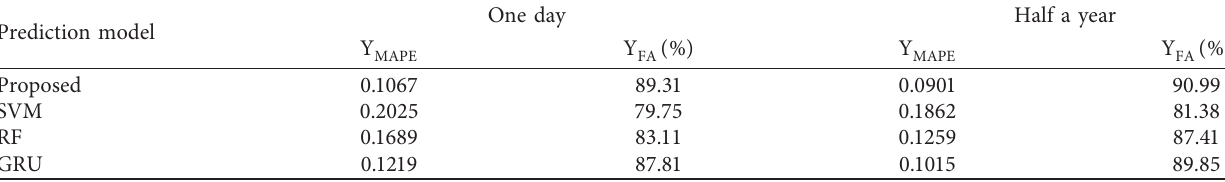
Table 1: Comparison of model prediction results.